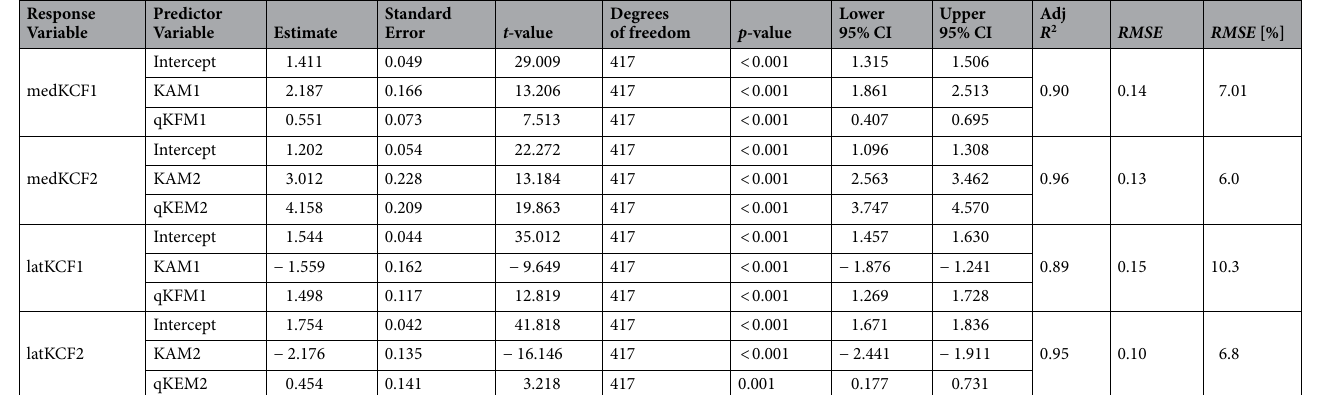
Table 2. Statistical summary of the linear mixed-effects models between the internal knee joint contact forces and external knee joint moments for the patient group. CI: Confidence interval; Adj. R 2 : adjusted R 2 ; RMSE : root mean squared error [BW]; medKCF1/medKCF2: max. value in the first/second half of stance of the medial knee joint contact force [BW]; latKCF1/latKCF2: max. value in the first/second half of stance of the lateral knee joint contact force [BW]; KAM1/KAM2: max. value in the first/second half of stance of the external knee adduction moment [Nm/kg]; qKFM1/qKEM2: squared maximal/minimal value in the first/ second half of stance of the external knee flexion/extension moment (KFM1, KEM2; [Nm/kg]).